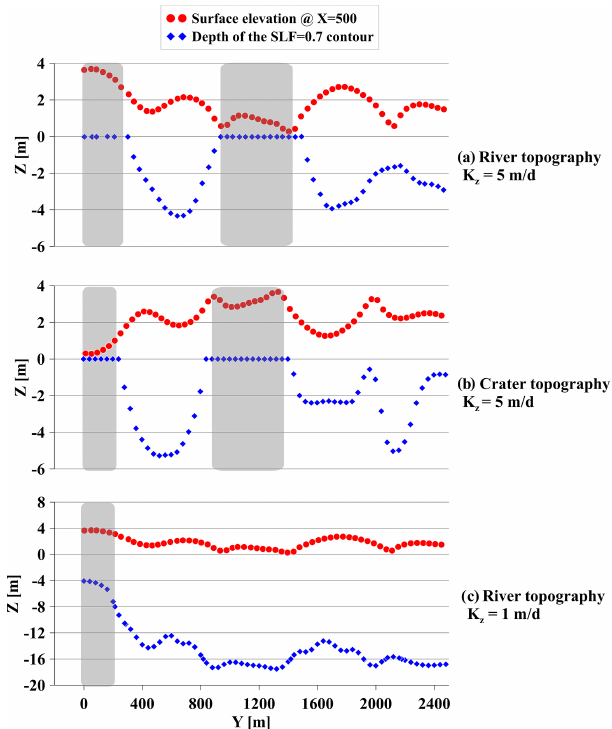
Figure 6. Topographic elevation at X = 500m (50m onshore of the shoreline, red circles) and depth of the SLF = 0.7 contour below the shoreline (blue diamonds) versus the alongshore coordinate Y for (a) the River topography with K z = 5md − 1 , (b) Crater topography with K z = 5md − 1 , and (c) River topography with K z = 1md − 1 . Deeper locations of the SLF = 0.7 contour (blue diamonds) mean thicker “critical layers”. The places where no significant critical layer develops (i.e., the elevation of the SLF = 0.7 contour is Z = 0) are marked by gray